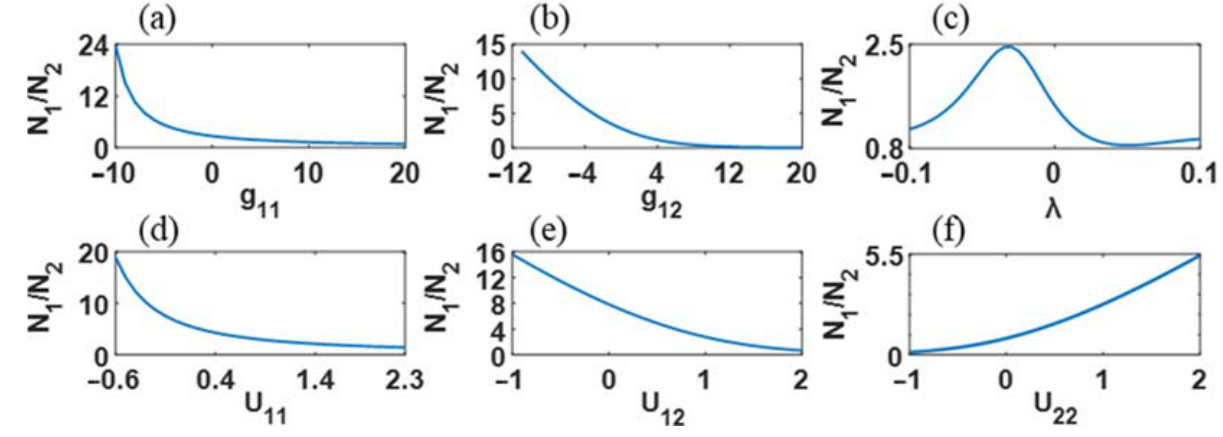
Photonics 2022 , 9 , x FOR PEER REVIEW 5 of 7